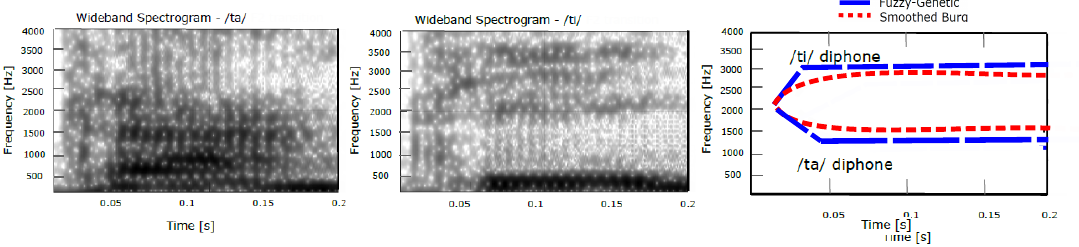
Figure 15. Second formant transitions of the / ti /, / ta /